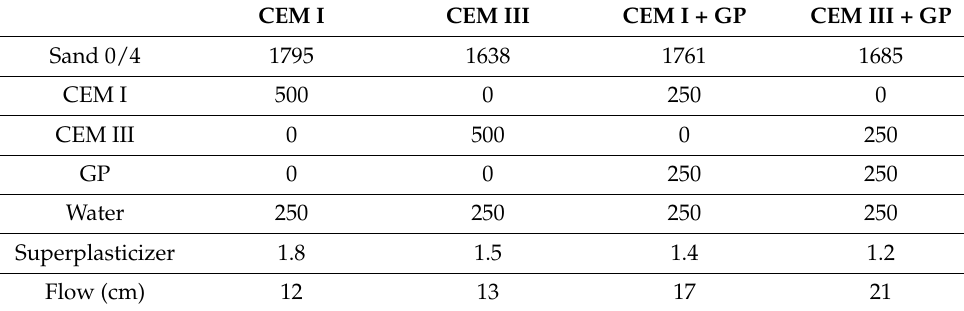
Table 3. Mix proportions of mortar (kg/m 3